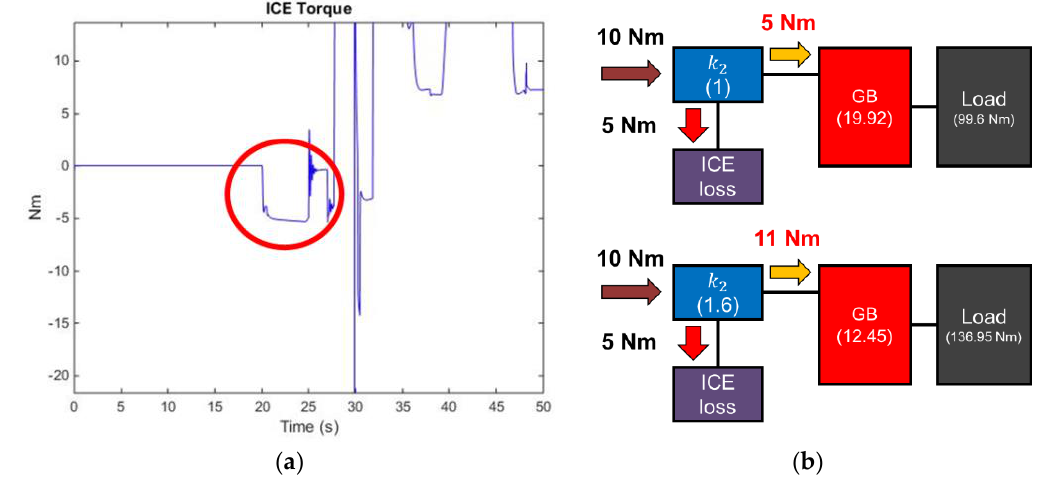
Figure 19. ( a ) Engine pumping loss. ( b ) Pumping loss inference in pre-transmission